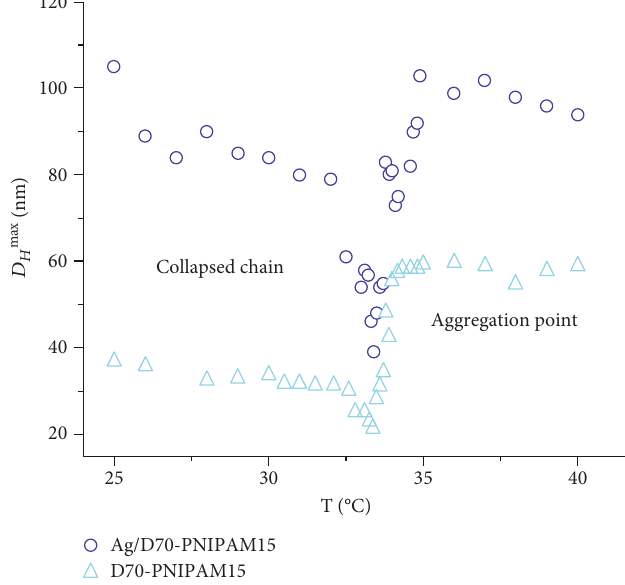
Figure 3: Temperature dependence of the hydrodynamic diameter for D-g-PNIPAM (individual macromolecule, black empty squares) and D-g-PNIPAM/AgNP nanosystems (Nanoobject 2, blue empty